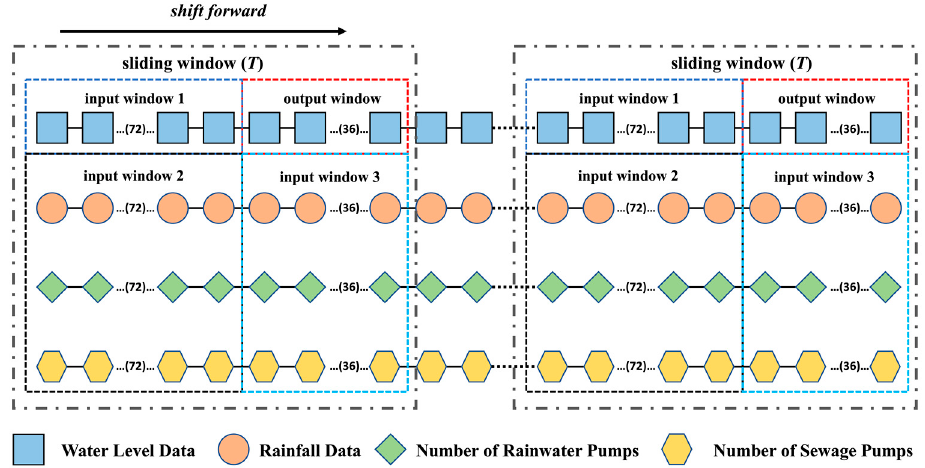
Figure 5. The sample processing process of the research